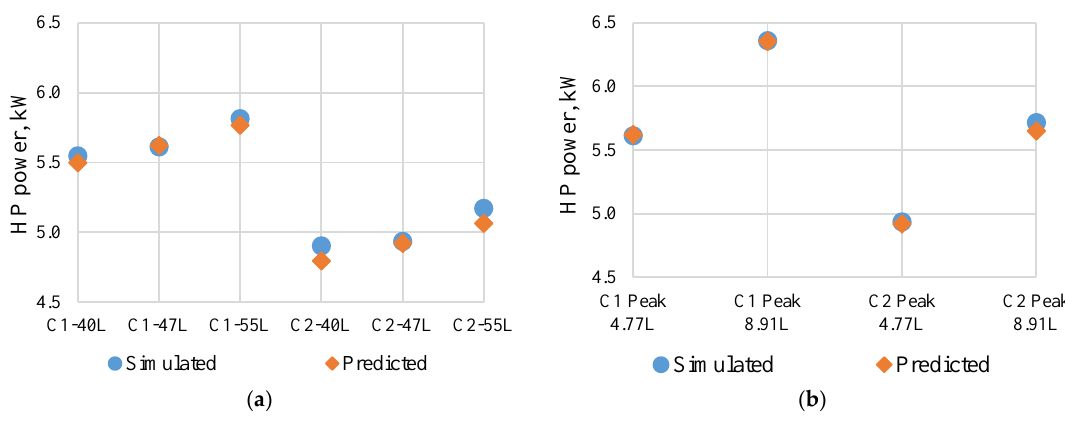
Figure 18. Simulated and predicted heat pump powers ( a ) for different DHW usage rate (L/person/day) ( b ) for different DHW usage peaks based on different DHW hourly profiles (C1 case refers without considering internal heat gains, C2 case refers with considering internal heat gains).